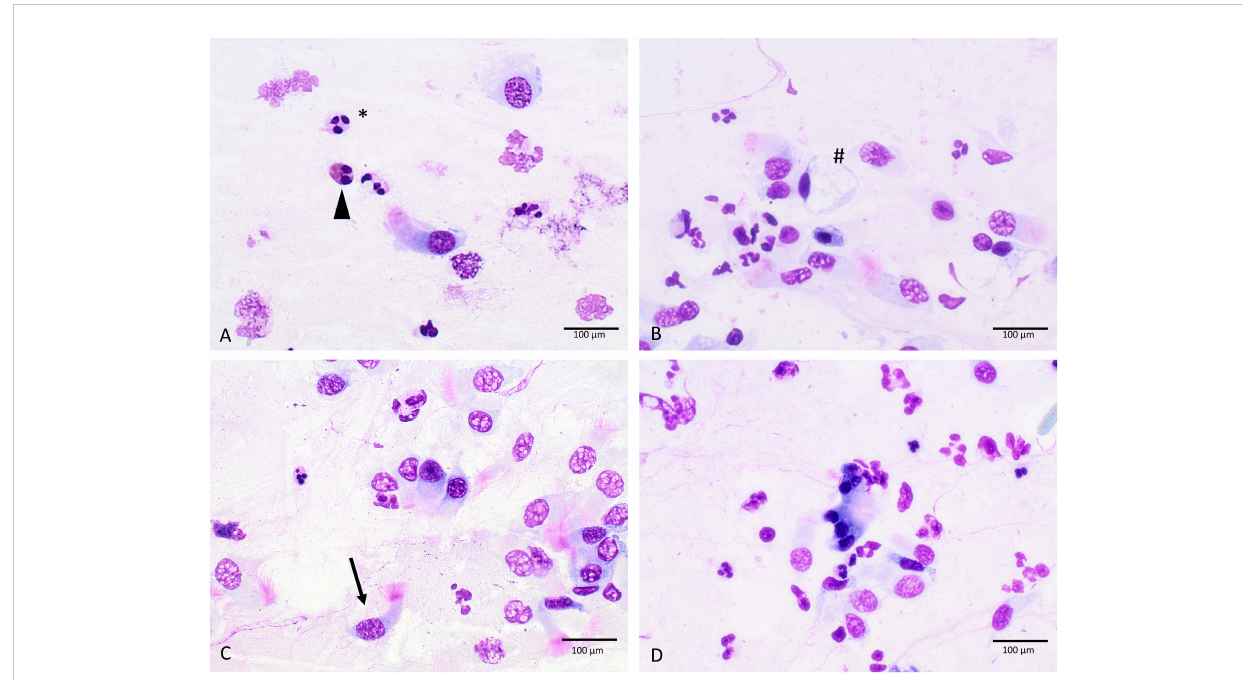
FIGURE 2 Cellular morphology in MGG-stained slides (A – D) , triangle, eosinophilic granulocytes; #, mucinous cell; *, neutrophilic granulocytes; arrow, ciliated cell; 60-fold magni fi